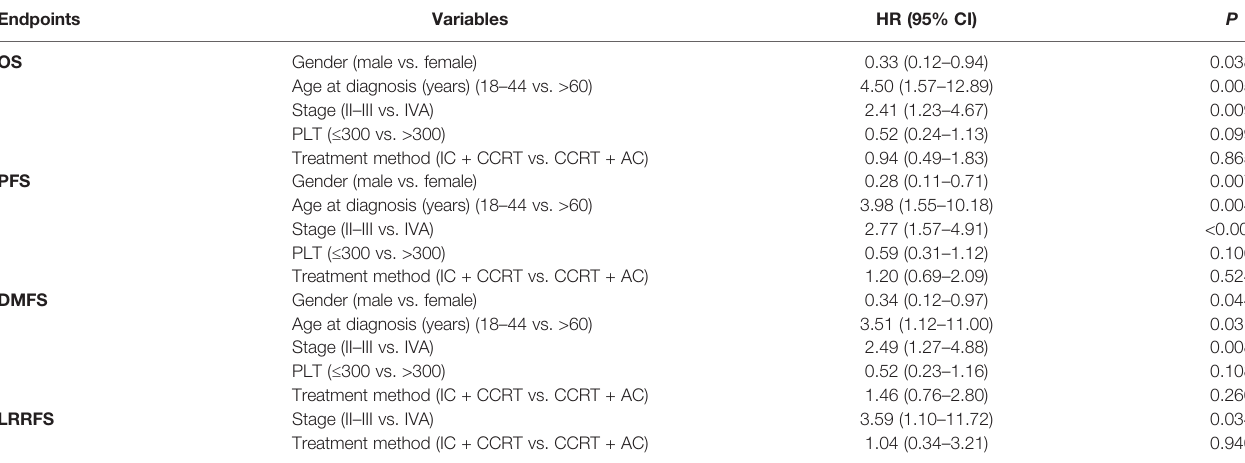
TABLE 3 | Multivariate cox analysis of prognostic factors for NPC patients after